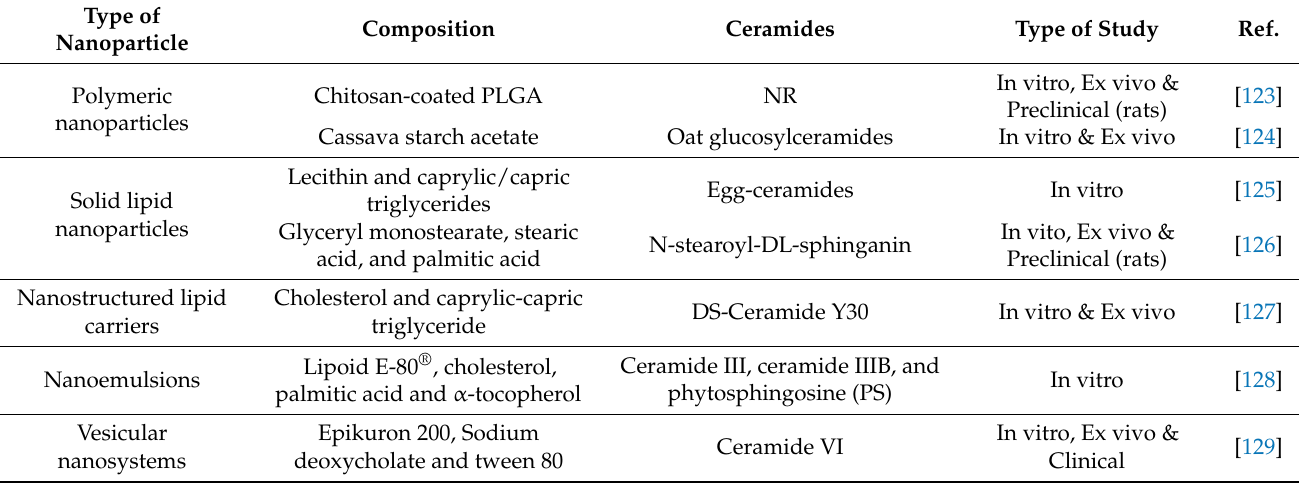
Table 3. Summary of ceramide-loaded nanodelivery systems designed for topical